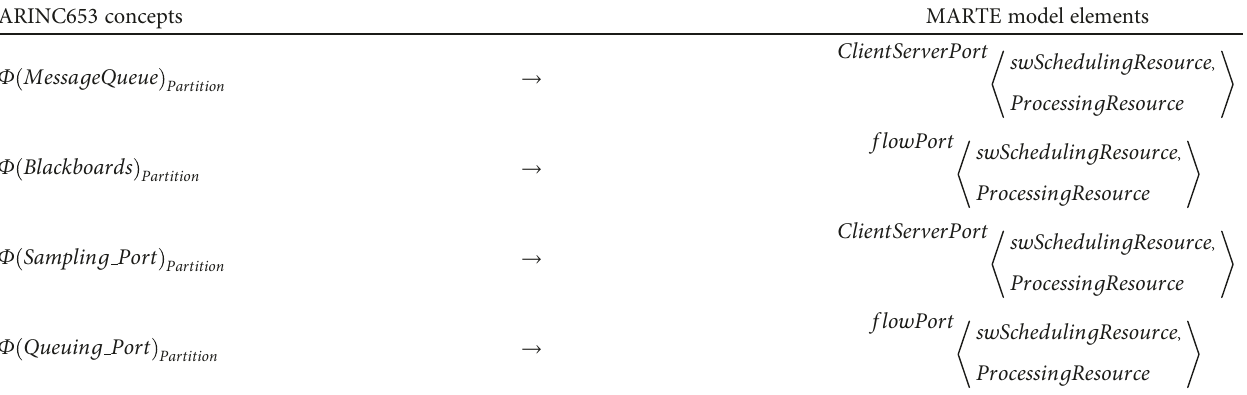
Table 6: Process communication transformation rules.